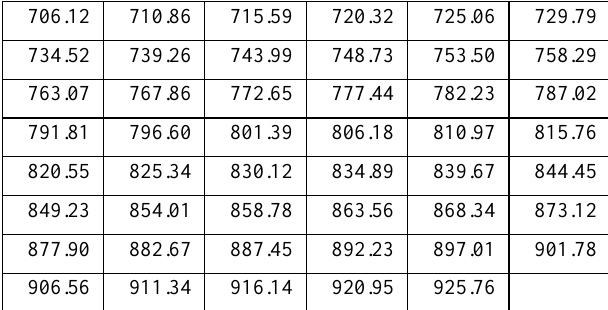
Table 1 AISA Eagle central wavelengths [nm] bands 1 to 107.